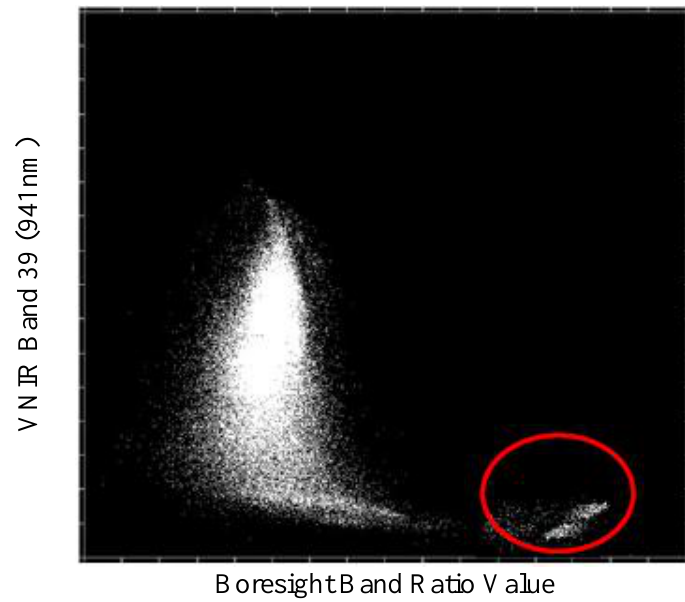
Figure 4. Scatterplot (286 × 400) computed from the boresight band ratios (boresight value) and VNIR band (941 nm). The isolated cluster (circled in red) represents the shadow regions in the image (validated by ground truth